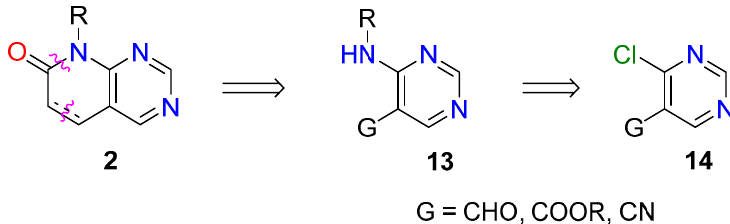
Figure 9. Synthetic approach for pyrido[2,3- d ]pyrimidin-7(8 H )-ones ( 2 ) from a preformed N -substituted pyrimidine-4-amine ( 13 ) bearing a carbon functional group G .